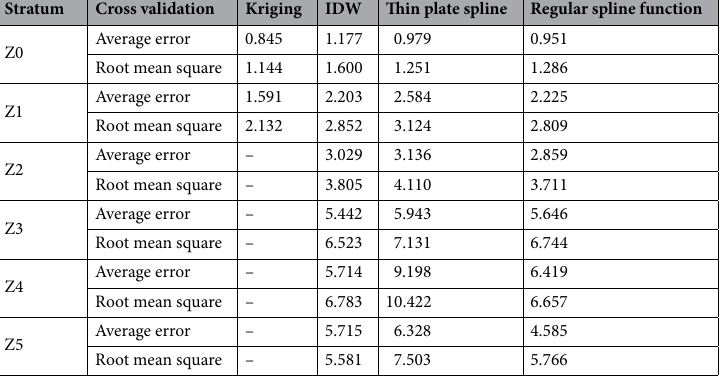
Table 2. Cross-validation